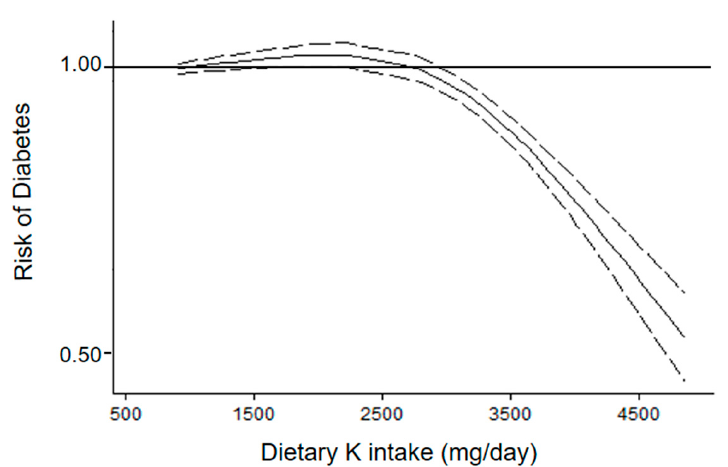
Figure 4. Dose–response association between dietary potassium (K) intake by questionnaire and risk of diabetes (six cohorts). Dietary potassium intake was modelled with restricted cubic splines in a multivariate random-effects dose–response model (solid line). Dashed lines represent the 95% confidence intervals for the spline model.